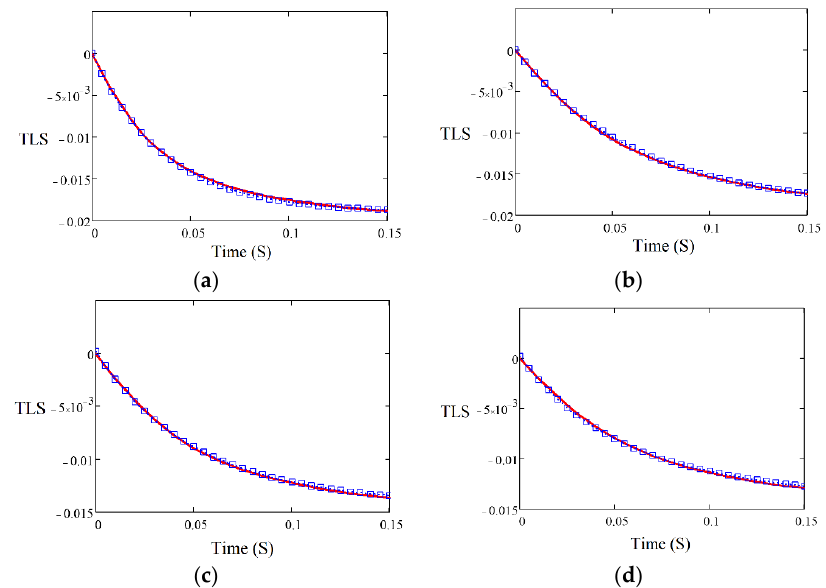
Figure 2. TLS signals for ( a ) HDPE, ( b ) LLDPE, ( c ) LDPE, and ( d ) PP as a function of time.